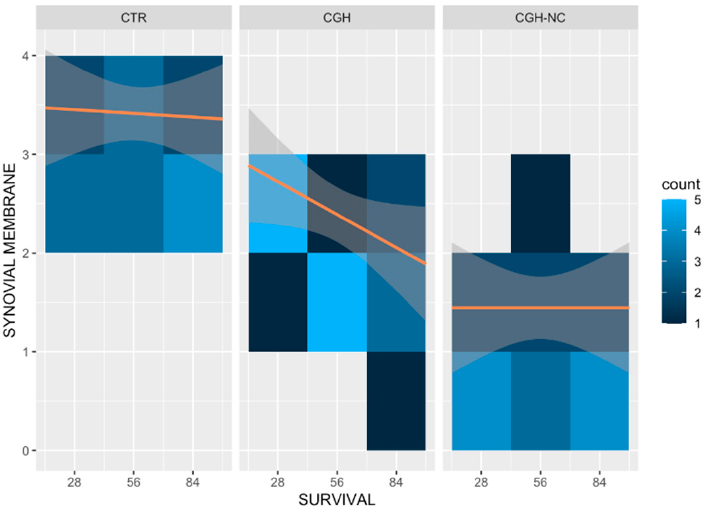
Figure 7. Synovial membrane histologic sections representative of each treatment group 84 days after surgery. Images from the CGH-NC group show a less hyperplastic appearance with only 2–3 synoviocyte layers, unlike the remaining groups. The black box shows the layers of sinoviocytes for each group.